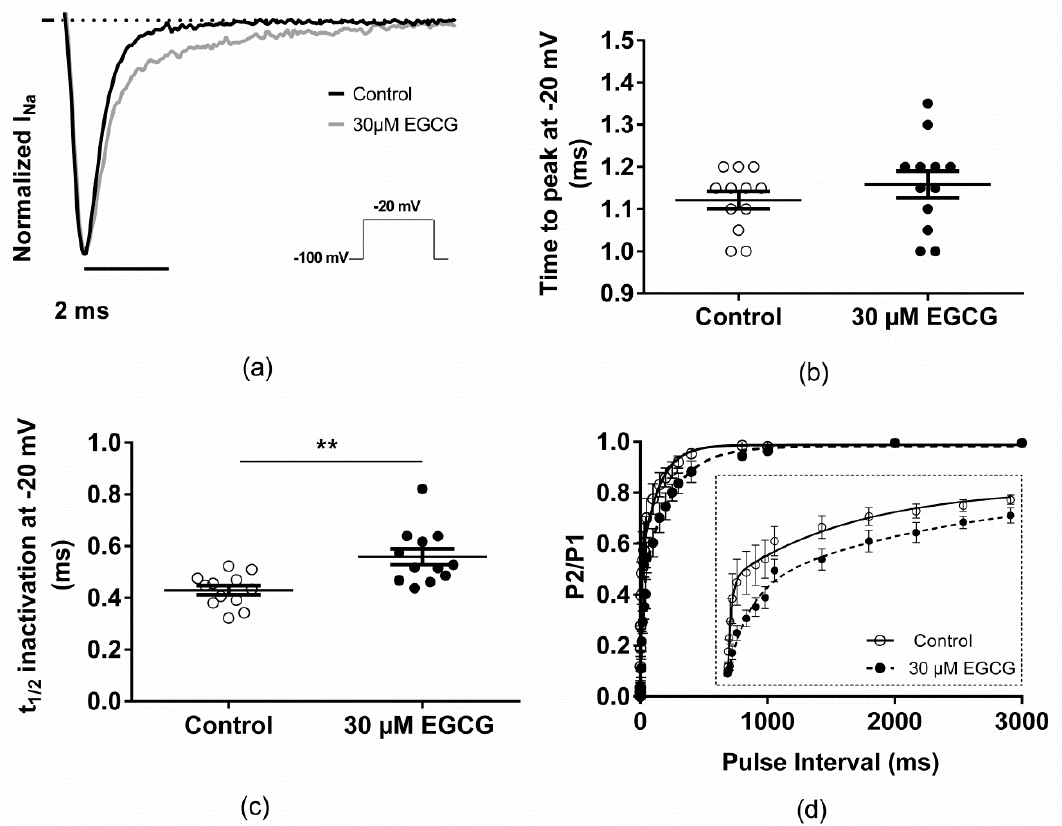
Figure 3. Effect of EGCG on I Na kinetics. ( a ) Representative traces of normalized I Na current in the presence or the absence of 30 µM of EGCG. I Na currents were normalized to the maximal peak current measured, in each condition, at − 20 mV. EGCG effect on I Na time to peak ( b ), inactivation kinetics ( c ), and recovery from fast inactivation ( d ; inset, zoom on the interval between 0 and 300 ms).